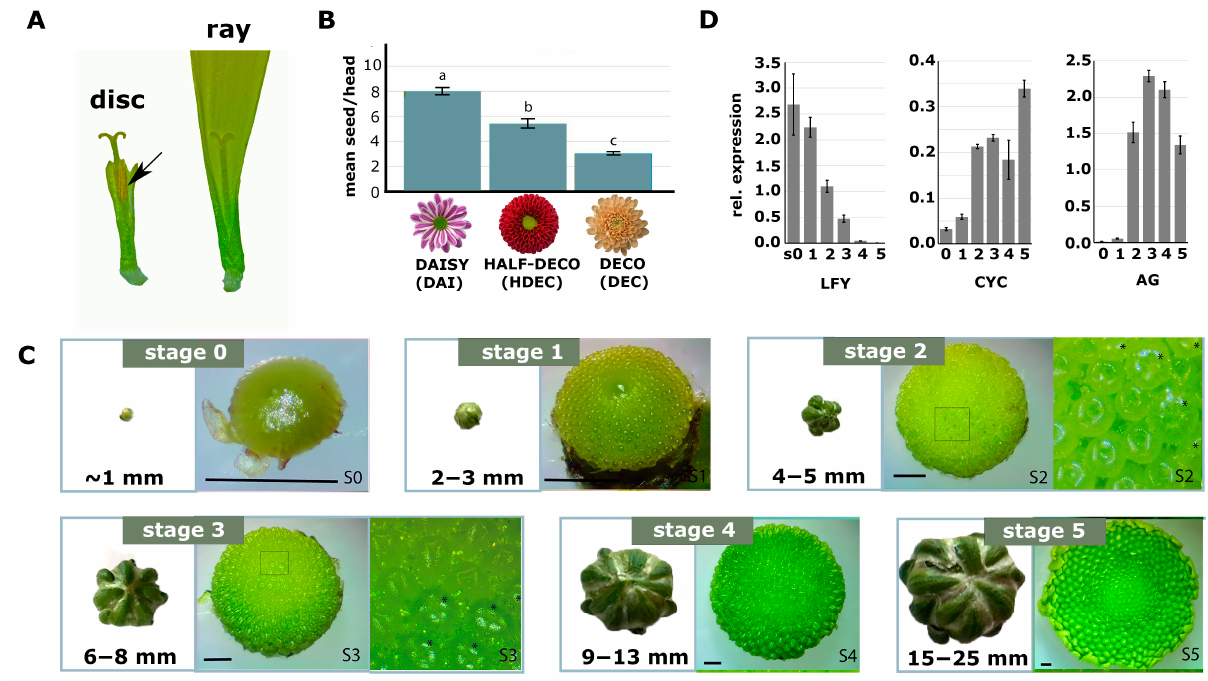
Figure 1. Chrysanthemum capitulum development and the correlation between seed set e ffi ciency and the relative number of disc fl orets in the capitulum. ( A ) Morphology di ff erences between a full-grown mature disc fl oret (left) and ray fl oret (right). The corolla tube of the disc fl oret was partially removed to display the anthers (arrow); the ray fl oret ligule was cut at the top. ( B ) Representative examples of a Daisy-type (DAI), Half-Decorative-type (HDEC), and a Decorative-type (DEC) capitulum, going from mainly disc fl orets to mainly ray fl orets, respectively. Per type, the average seed set on a single capitulum is shown upon hand pollination with the same amount of pollen. ( C ) Six subsequent developmental stages (S0–S5) of a chrysanthemum capitulum. For each stage, the closed capitulum bud is shown on the left. Next to it on the right, dissected capitulum buds are shown in which the initial stages of fl oret development are visible. For S2 and S3, part of the capitulum (boxed region) is enlarged. In this zoom-in representation, the radially symmetrical disc fl orets (marked with an asterisk) can be distinguished from zygomorphically symmetrical ray fl orets. ( D ) Expression of LFY , AG , and CYC2c in the six capitulum developmental stages as determined by qRT-PCR. Signi fi cance in ( B ) determined by ANOVA, p < 0.05. Error bars represent standard error. Number of measurements: DAI, 7486; HDE, 3086; DEC, 17,987. Size bar in ( C ) = 1 mm .